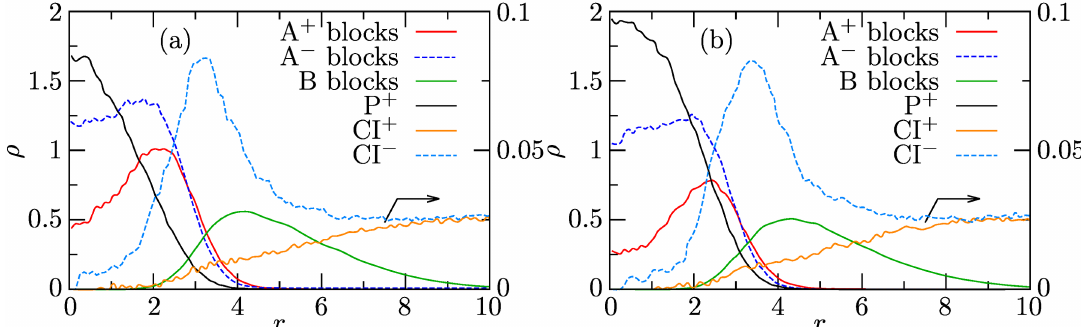
Figure 9. Radial density profiles, ρ , of associates from the system with 120 P + composed on average of ( a ) 14.6 PE + , 15 PE − , and 9.0 P + and ( b ) 12.1 PE + , 15 PE − , and 15.2 P + .